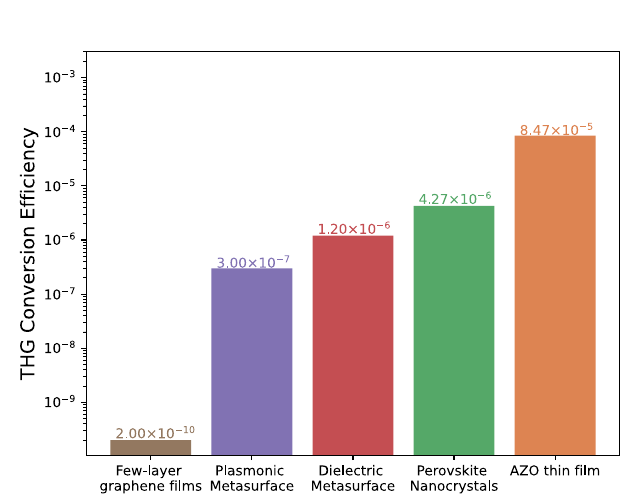
The table links the frequency conversion ef fi ciencies of different experimentally tested fl at systems to both fl uence levels and pulse